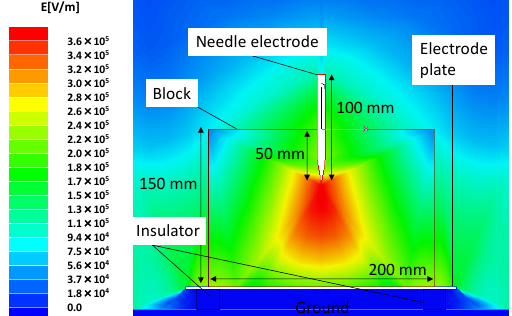
Figure 12. Electric field distribution inside of Lyophyllum deeastes Sing. Sawdust block for applied voltage of 30 kV.